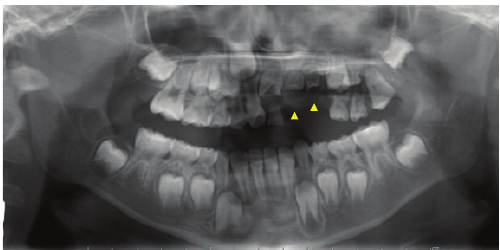
Figure 3: Panoramic radiograph at age 8 years and 4 months (case 1). Dental follicles of permanent affected teeth have irregularly expanded